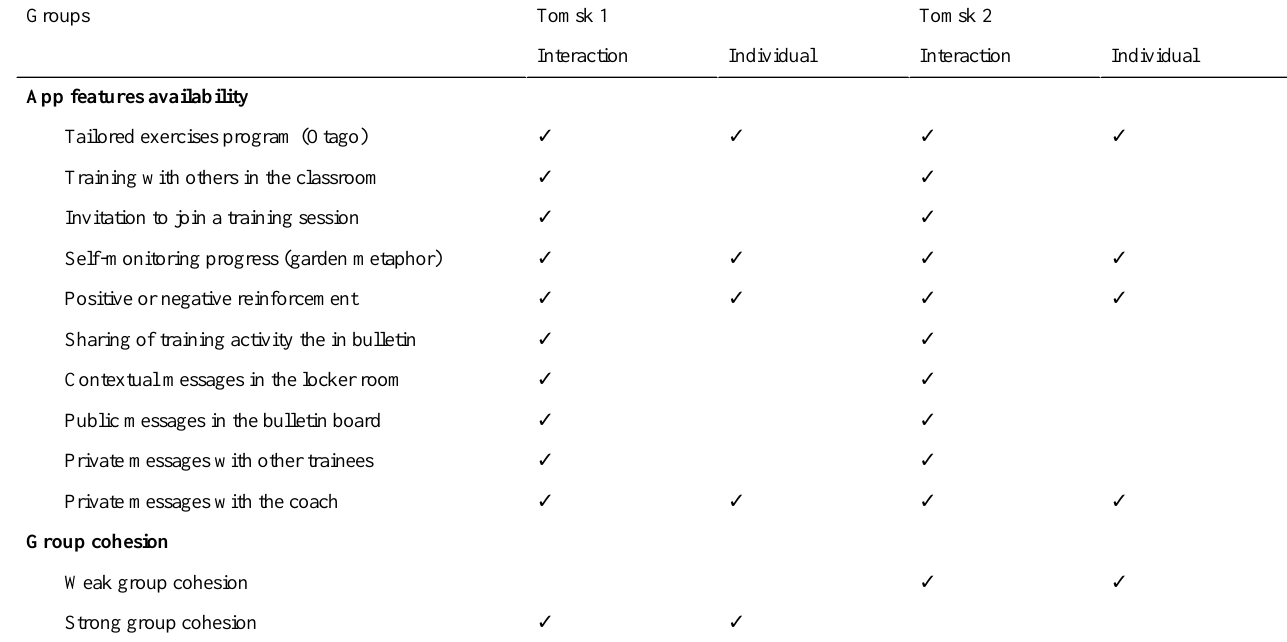
Table 1. Group cohesion and features of the trainee app available to each study group. Presence of the features in the version of gymcentral application used in each study group are denoted by checkmarks ( ✓